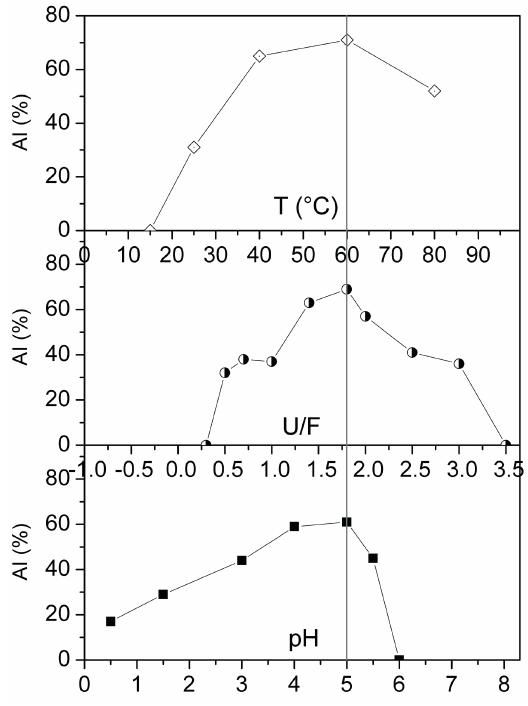
Figure 10: Optimizing synthesis